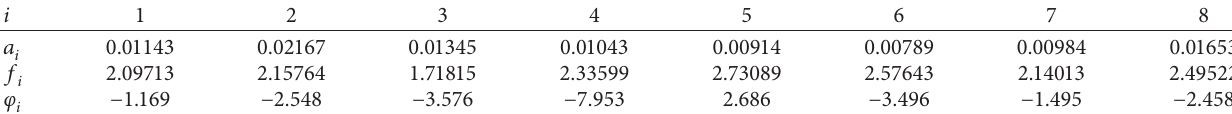
Table 2: Values of 24 fitting parameters in equation (1) in 20 ∼ 40s.